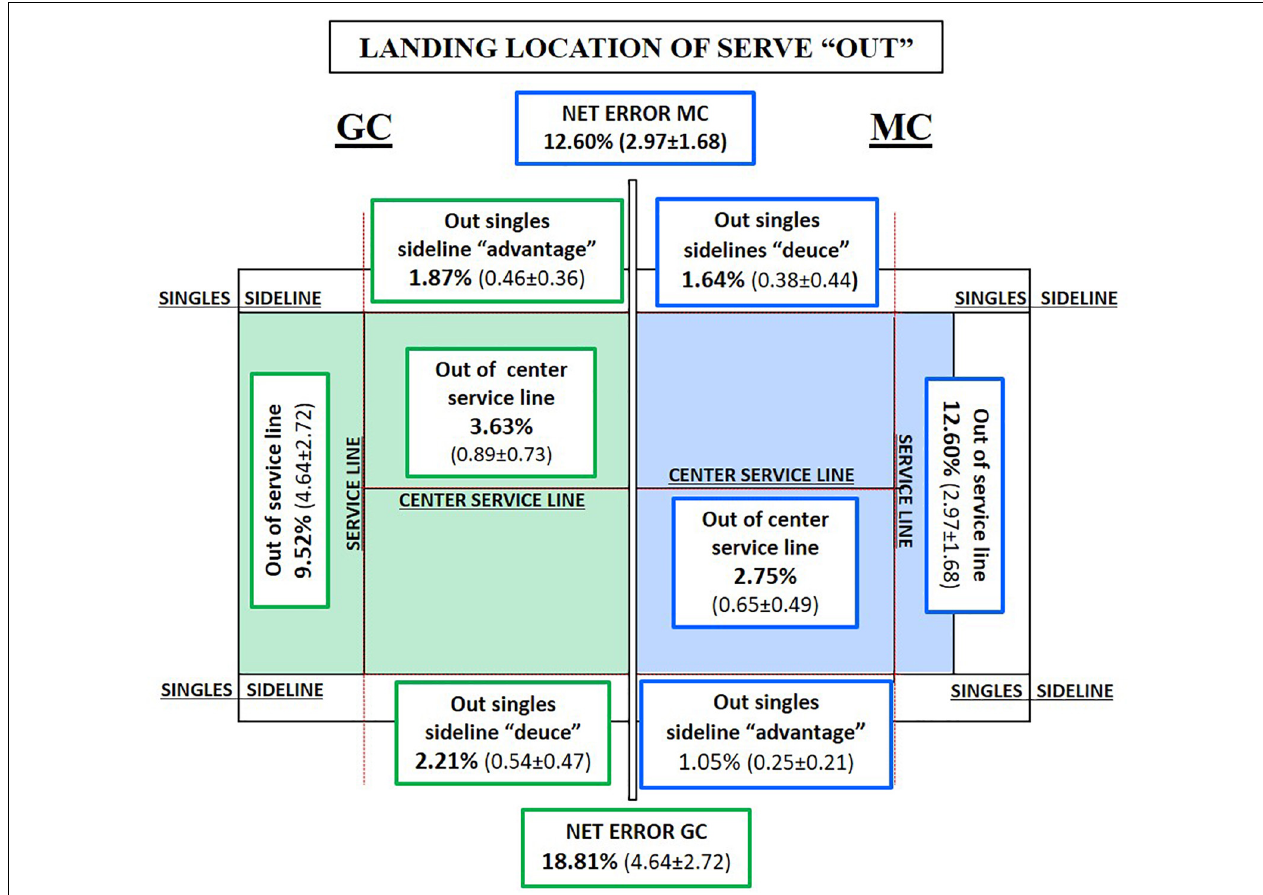
FIGURE 4 | Percentage and mean per match of the landing locations of the serve “out” per match in both competitions (Tennis 10s Green Competition “GC” = green color and Modified Competition “MC” = blue color).